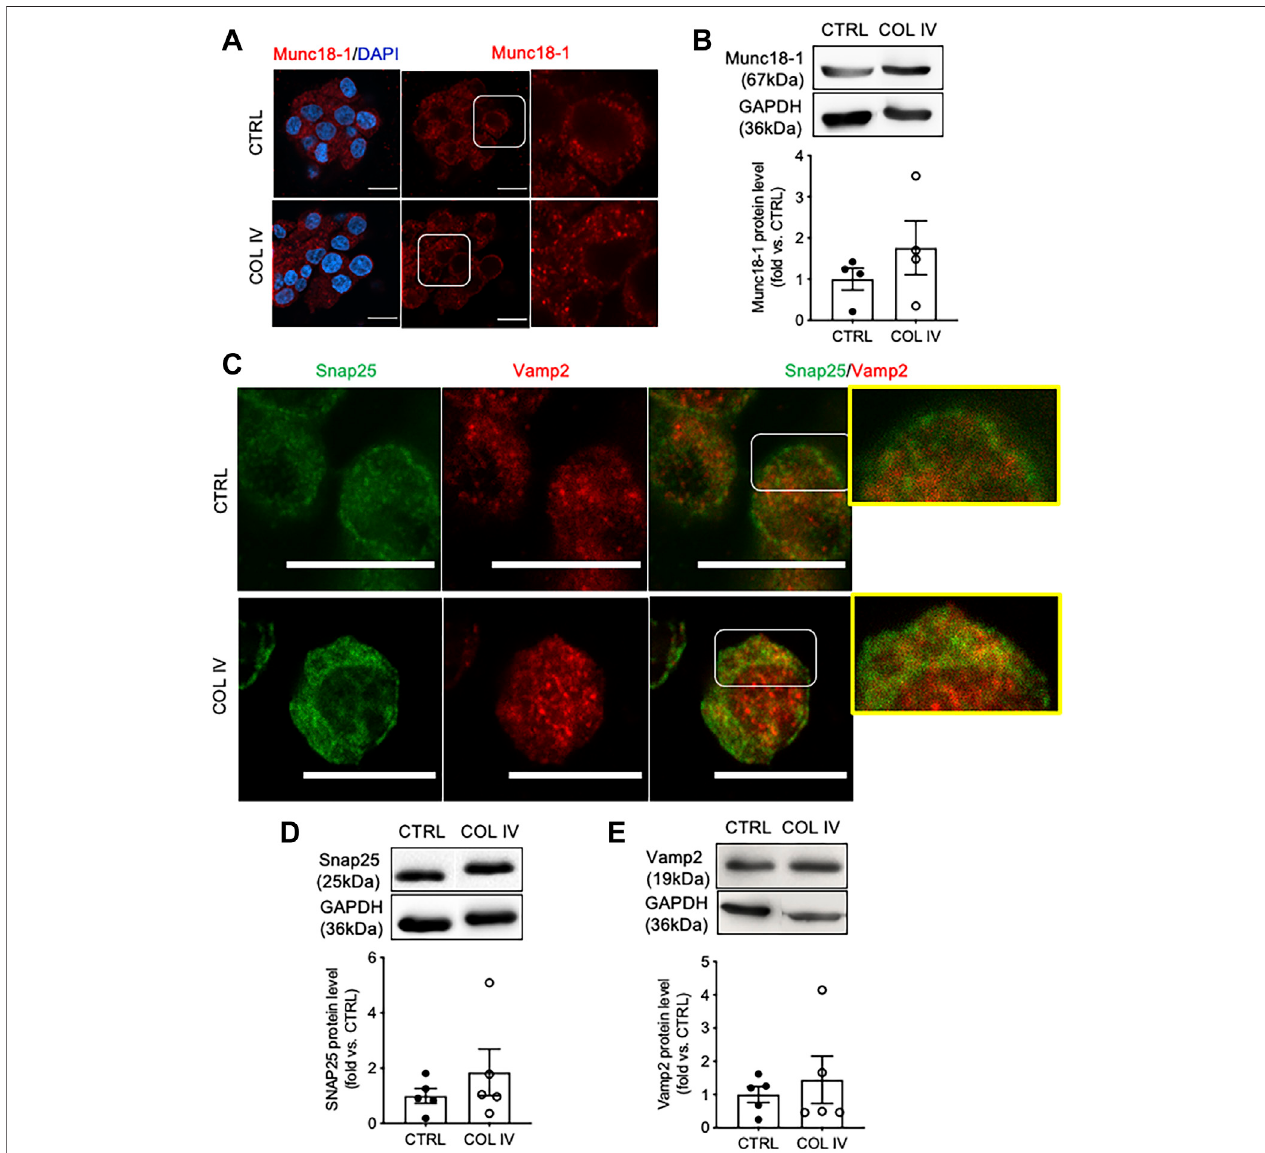
FIGURE 3| Collagen IV impacts SNARE protein level and colocalization in INS-1 cells. Representative (A) Munc18-1 (red) immunostainingand (B) blotting images and quanti fi ed data. Double immuno fl uorescence staining for (C) Snap25 (green) and Vamp2 (red); representative blotting images and data analysis for (D) Snap25 and (E) Vamp2 in INS-1 cells cultured on collagen IV (COL IV) or BSA-coated control (CTRL) for 24 h. Nuclei are counterstained with DAPI, and magni fi ed images are highlighted. Scale bar: 10 µm. Data are expressed as mean ± SEM ( n = 4 – 5